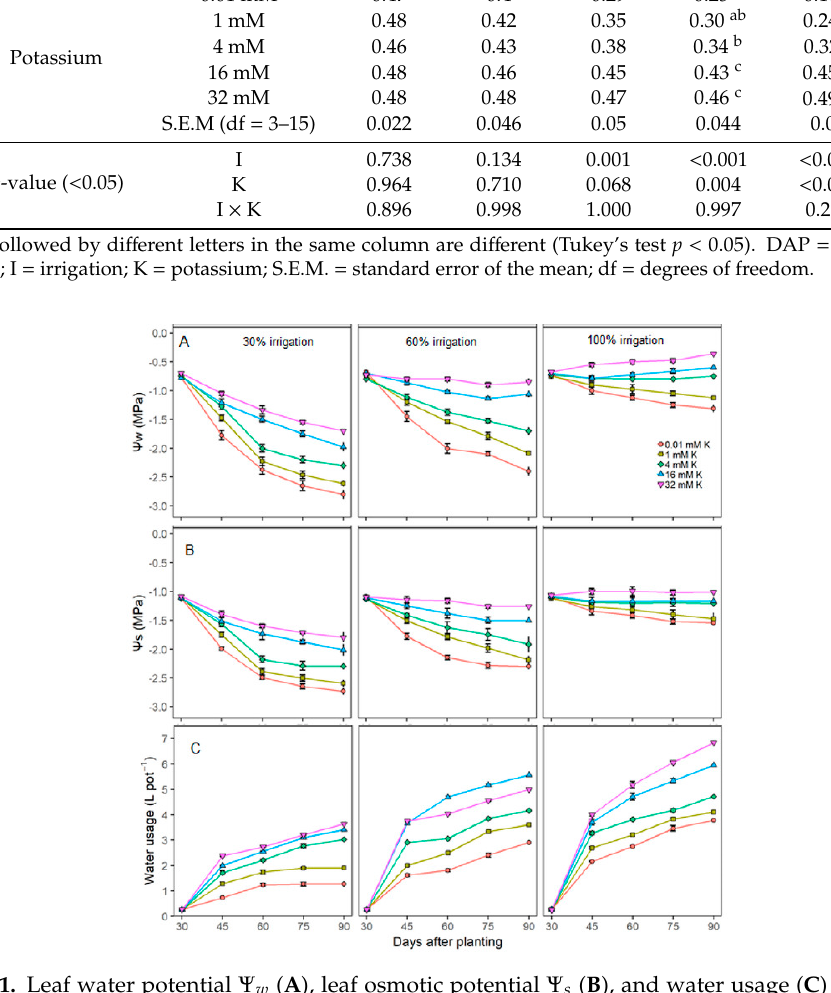
Figure 1. Leaf water potential Ψ w ( A ), leaf osmotic potential Ψ s ( B ), and water usage ( C ) of young cassava plants in response to deficit irrigation and K fertigation. The treatments were initiated 30 days after planting and lasted 60 days. The data from four separate experiments were combined and shown as the means ± standard error of 4 to 16 replicate plants.